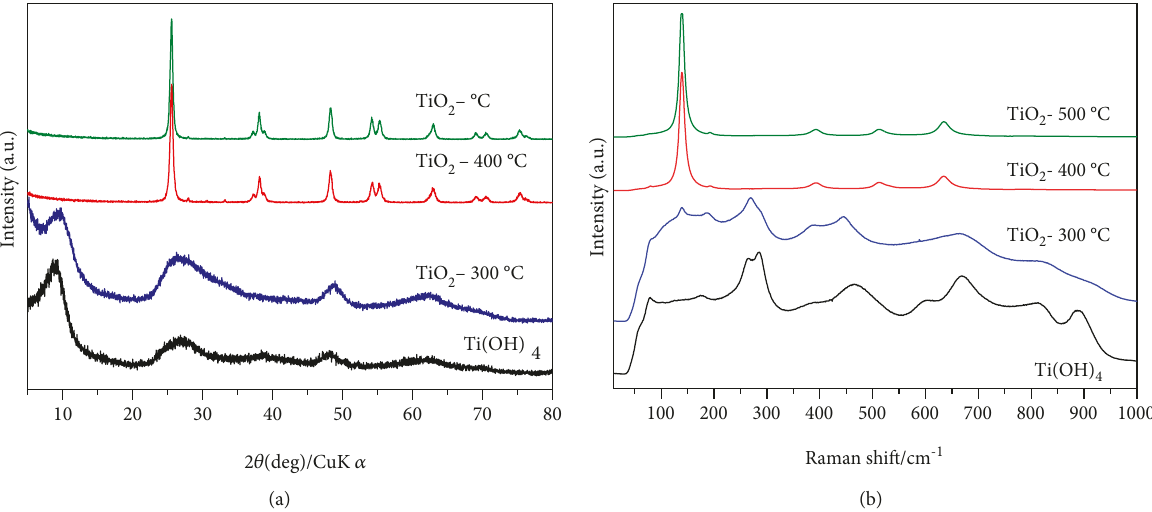
Figure 3: XRD patterns (a) and Raman spectroscopy of Ti(OH)